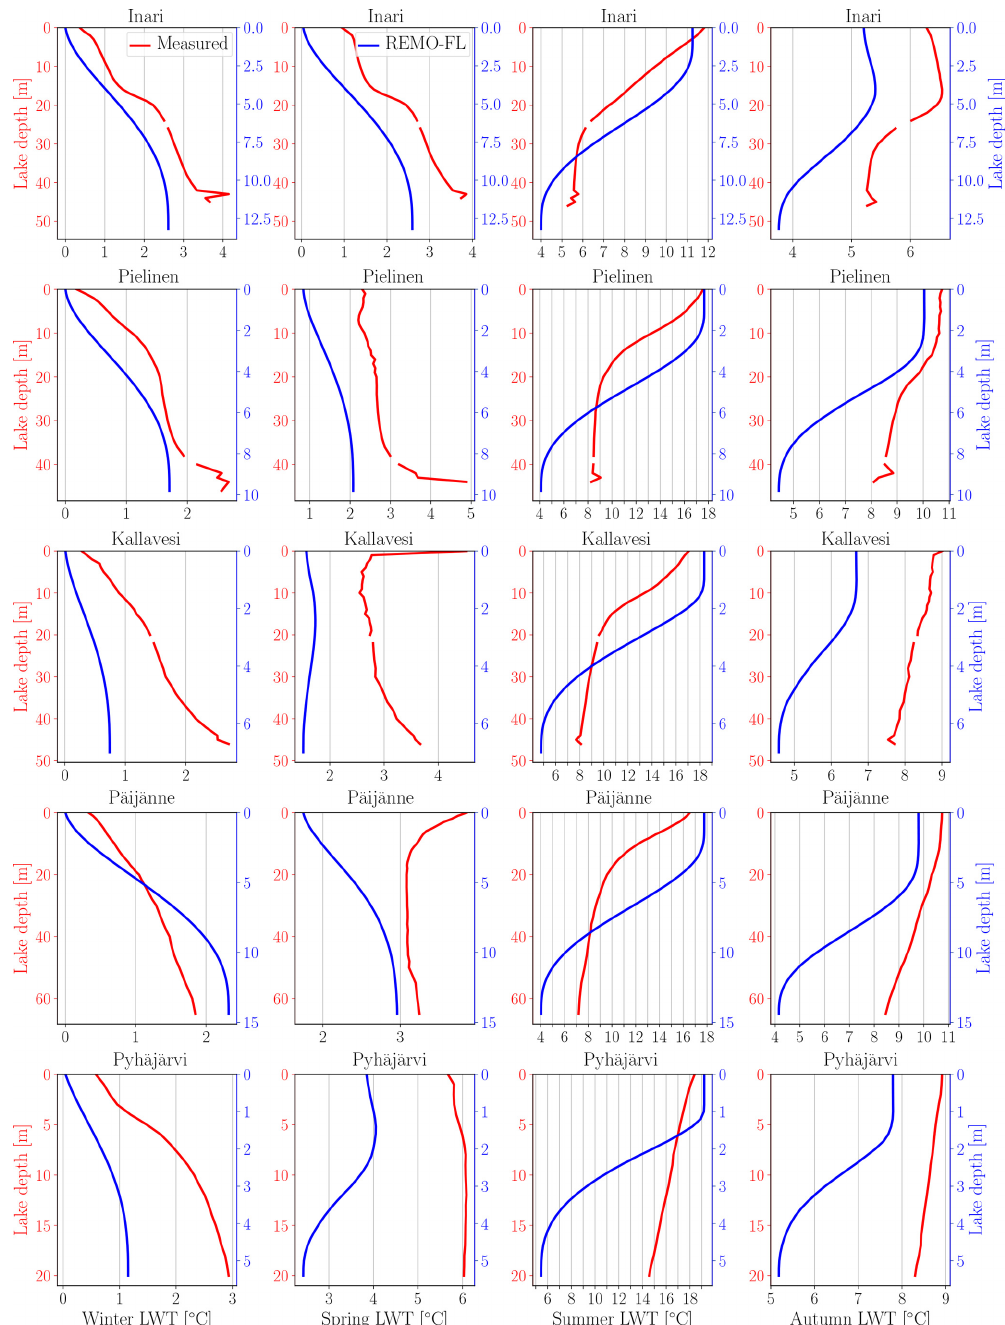
Figure 8. Vertical profiles of the measured and modeled seasonally averaged lake water temperatures (LWTs) in different lake depths. The values have been averaged for the time period of 1979–2015. The lake depth is shown for measurements (red color) and model results separately (blue color). Also, we have averaged the model results only over days when measurements were available because the measurement frequency was low (a few times per